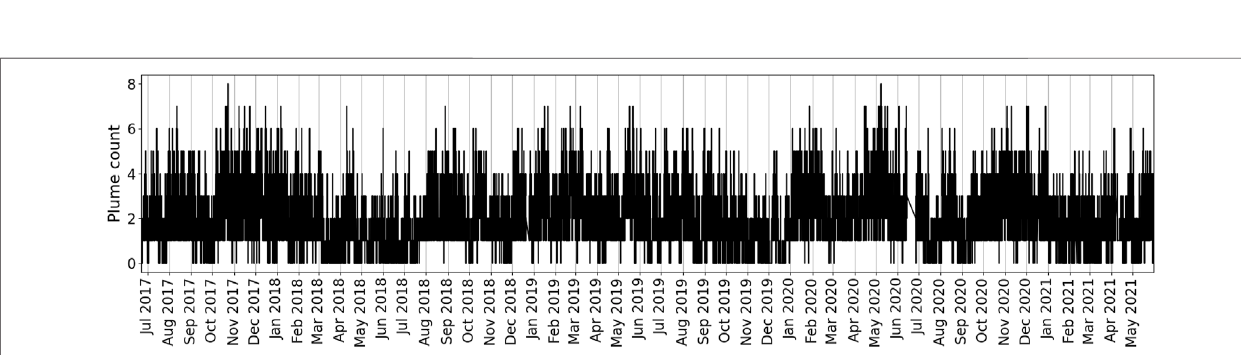
Frontiers in Earth Science |